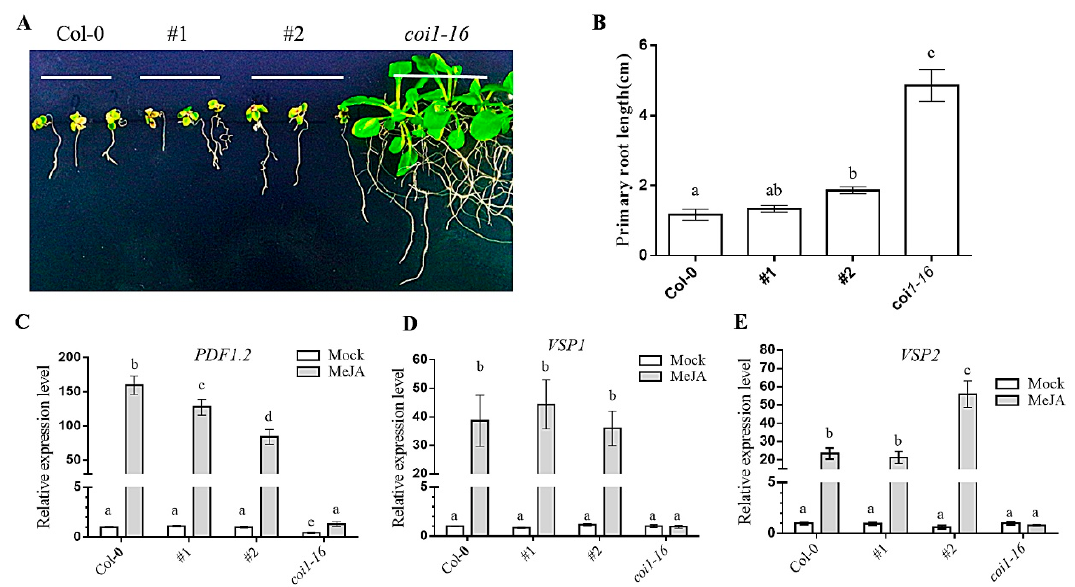
Figure 6. Sensitivity to MeJA of Col-0, complemented lines #1 and #2, and coi1-16 mutant. Growth of Arabidopsis thaliana seedlings on MS supplemented with 50 μ M MeJA ( A ); primary root length (N > 10) of seedlings after growing on MS supplemented with 50 μ M MeJA for 10 days ( B ); the expression of COI1-dependent and JA-responsive genes in Arabidopsis seedlings of different backgrounds (( C ), PDF1.2 ; ( D ), VSP1 ; ( E ), VSP2 ). The error bar represents the mean (±standard error) of at least three biological replicates. Columns marked with different letters ( a – c ) are significantly different from the others (ANOVA followed by Tukey’s multiple comparison test ( p < 0.05)).